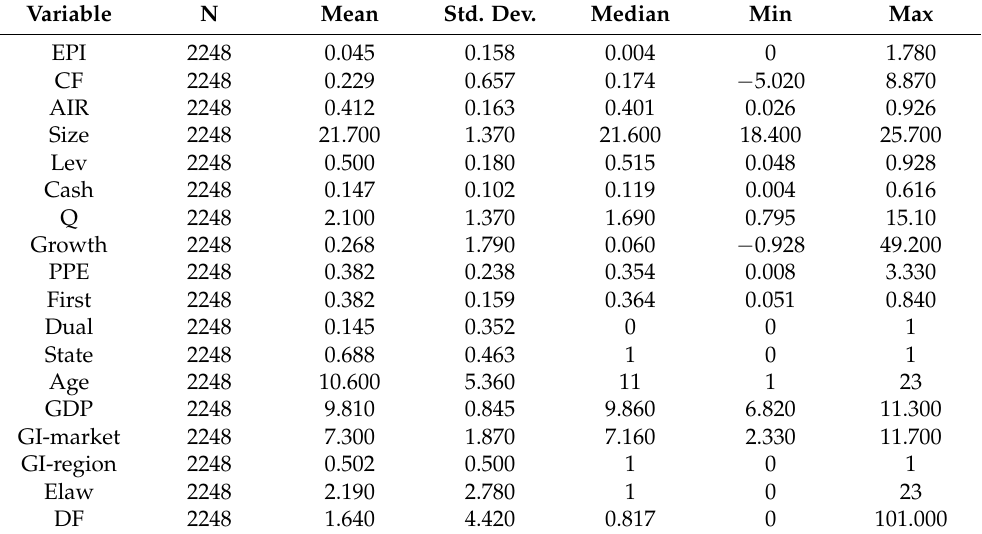
Table 2. Descriptive statistics.